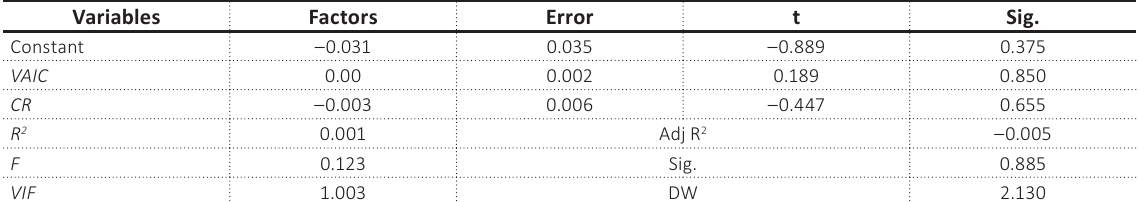
Table 7. The first model (companies with negative profits)